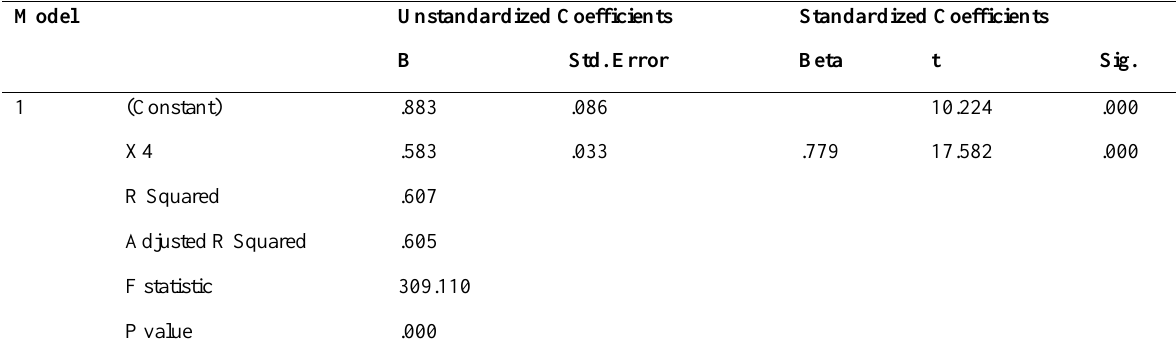
Table 2: Regression Model- Lean Supply Chain Strategy and Firm Performance